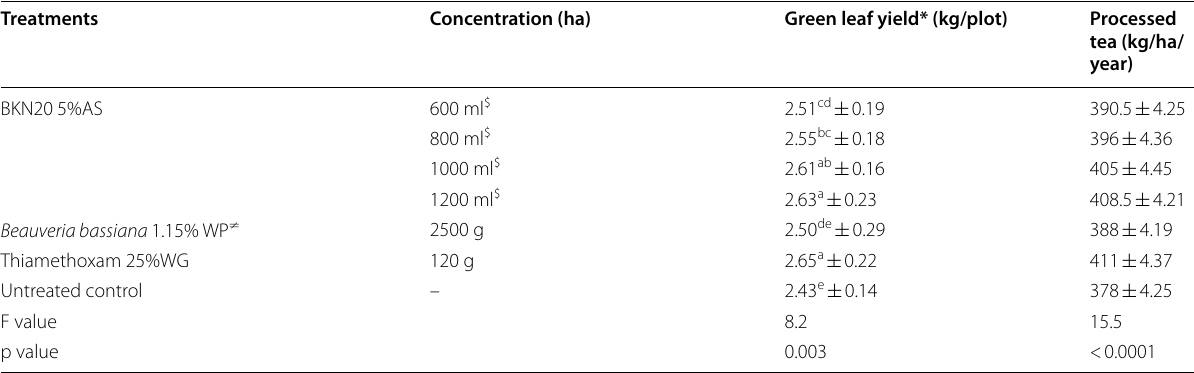
*Values represent the mean of three replications SE, for green leaf yield (obtained from six rounds of leaf plucking after treatments at weekly interval for two ± consecutive seasons) $ Containing 2 10 7 conidia/ml. Values in the same column followed by the same letter are not significantly different from each other at the 95% confidence interval × ( p < 0.05) using Tukey’s post-hoc Honestly Significant Difference (HSD) test ≠ Market